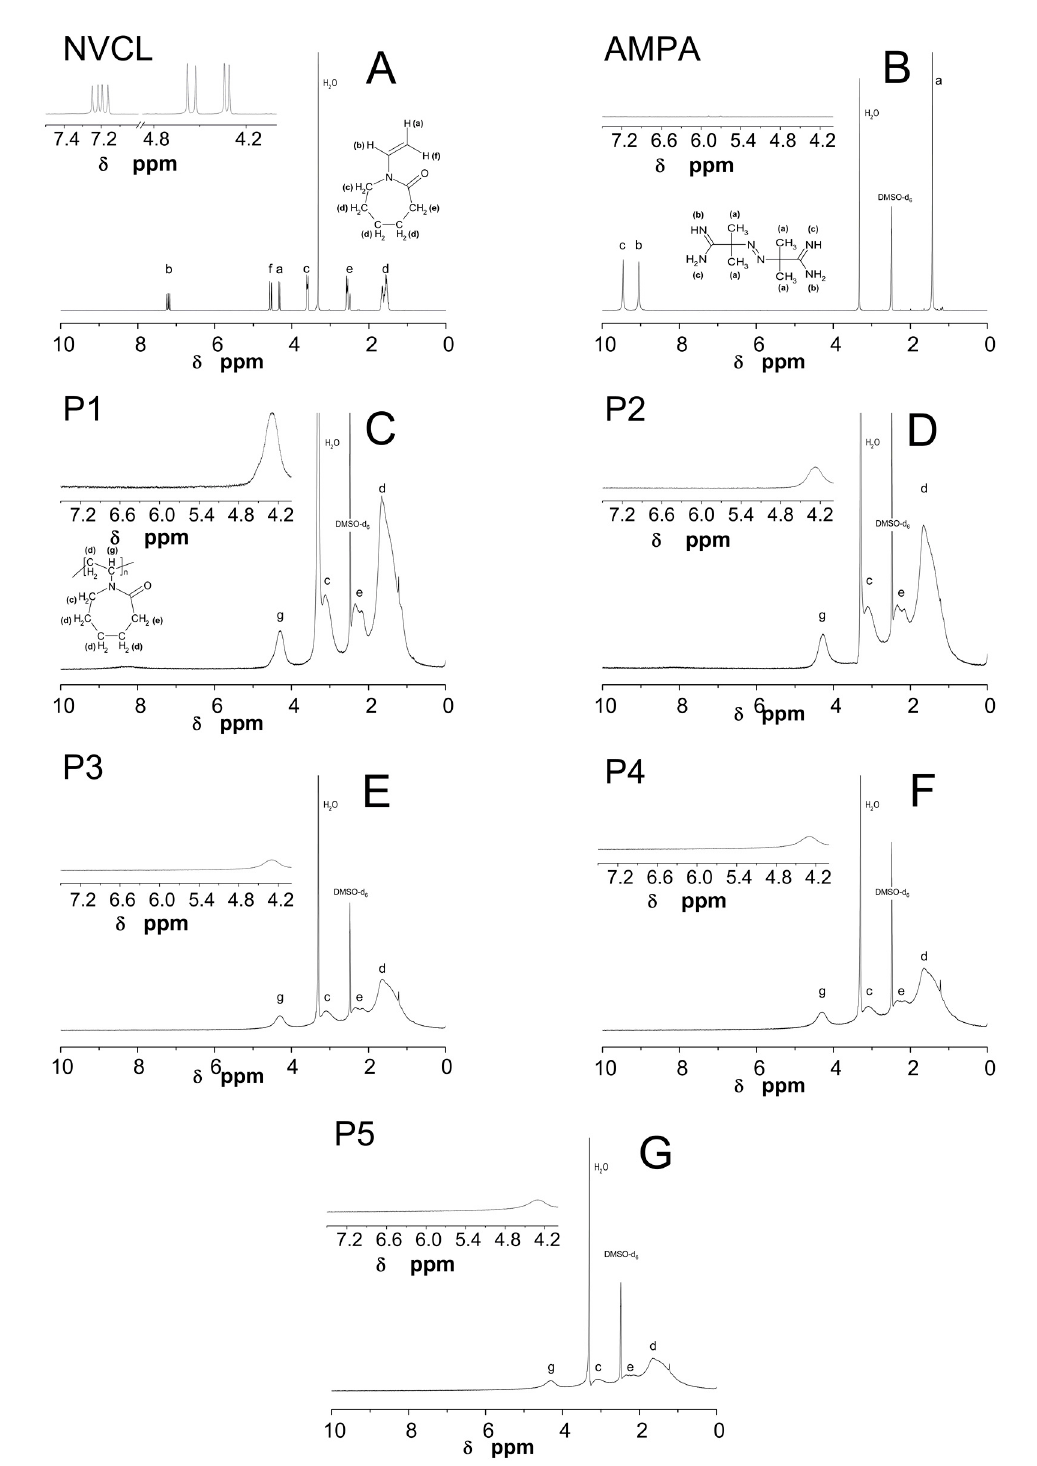
Figure 6. 1 H NMR spectra of monomer NVCL ( A ), initiator AMPA ( B ), and five synthesized polymers P1 ( C ); P2 ( D ); P3 ( E ); P4 ( F ); and P5 ( G ). The expanded areas in the 1 H NMR spectra present the resonance range of the vinyl protons.